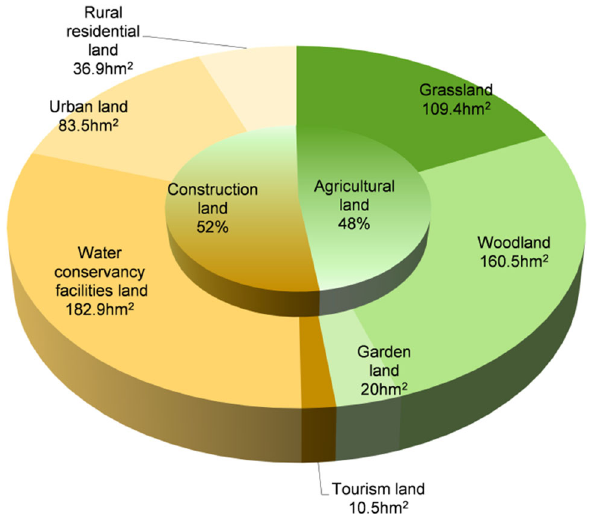
Fig. 8 Statistical chart of spatial structure optimization results of abandoned mine land reuse in Mentougou